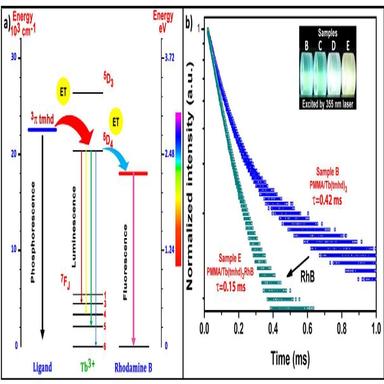
a) Energy transfer diagram and b) 5 D4 state lifetime of sample B and Sample E. The inset shows Samples B to E irradiated with a 355 nm laser.